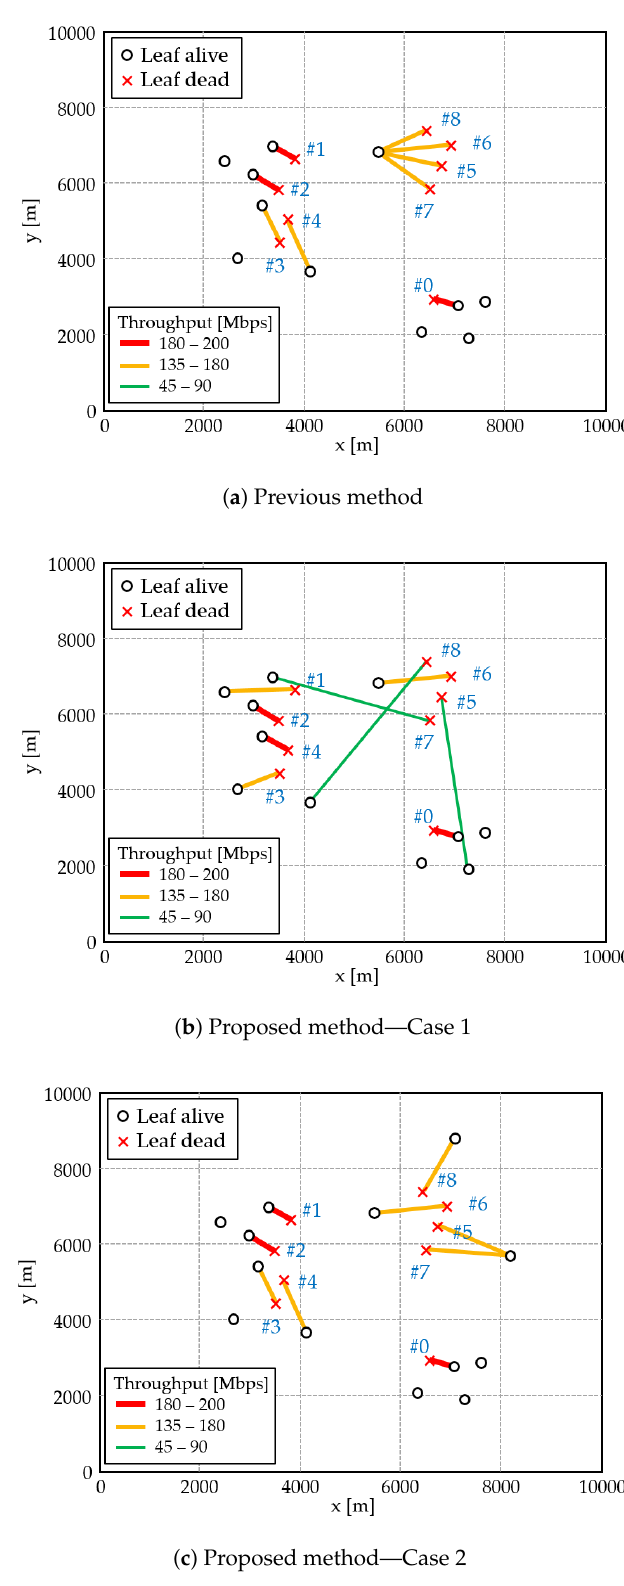
Figure 8. Simulated topology and routing